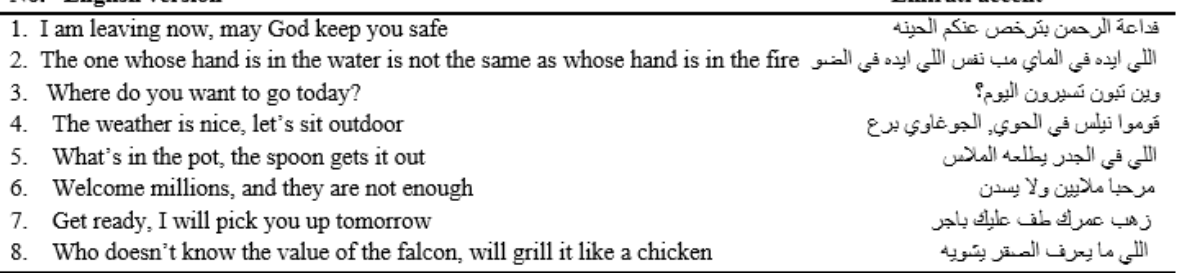
Figure 1. The Emirati dataset and its English